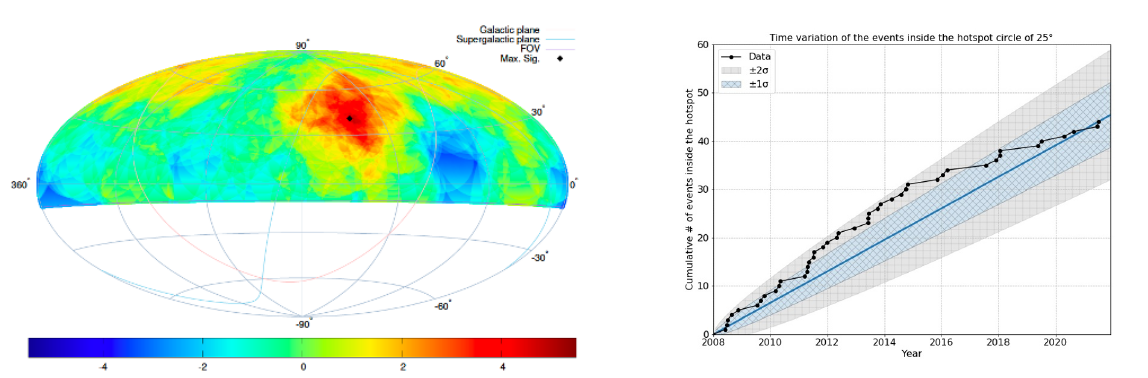
Figure 1. The sky map of the TA hotspot and the increase rate of events inside the hotspot circle. (Left) It is shown that the Li-Ma significance using a 25 ◦ -circle angular window in equatorial coordinates for 14 years of SD events with energies greater than 57 EeV. The black diamond indicates the maximum Li-Ma significance position at (144 . 0 ◦ , 40 . 5 ◦ ). The color code indicates an excess (red) and a deficit (blue) of events compared to isotropy. (Right) The black dots represent the cumulative number of events inside the hotspot circle of 25 ◦ from the most significant excess to the isotropy at (144 . 0 ◦ , 40 . 5 ◦ ). The blue solid line indicates the estimated event rate inside the hotspot. The light blue and gray bands show ± 1 σ and ± 2 σ deviations from the linear increase